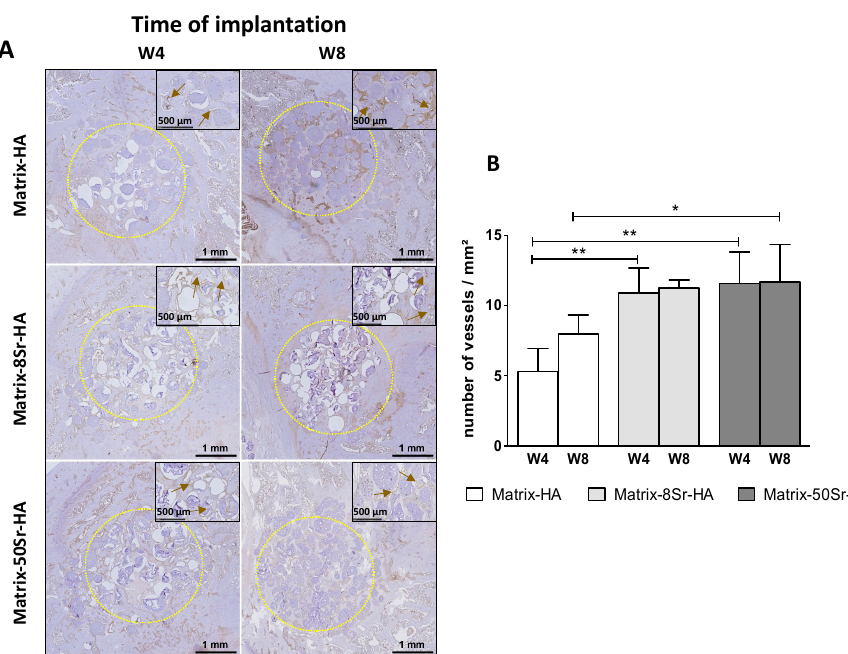
Figure 4. Histological analysis of the newly formed tissue the within the Matrix-HA groups supple- mented or not with strontium: ( A ) Masson’s trichrome staining of the newly tissue formed within the three groups of microbeads 4 (W4) and 8 weeks (W8) after implantation within the femoral condyle bone defect. The defect is represented with the black dote circle. ( B ) Quantitative analyses of the newly bone surface in mm². Results are expressed as average ± SD per group of microbeads (Matrix-HA, Matrix-8Sr-HA, and Matrix-50Sr-HA) with time of implantation (4 and 8 weeks: W4, W8). The symbols * and *** denote p < 0.05 and p < 0.001, respectively.